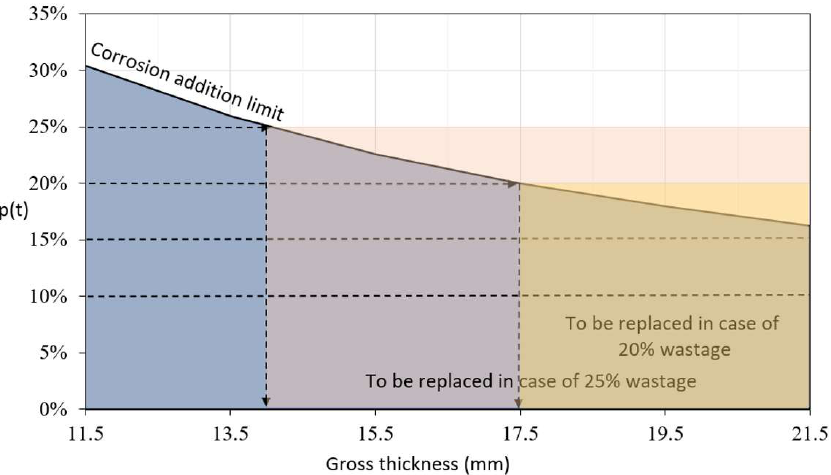
Figure 1. Gross thickness and corrosion addition percentage plotted against the corrosion wear percentage of gross thickness with corresponding criteria for the LG of bulk